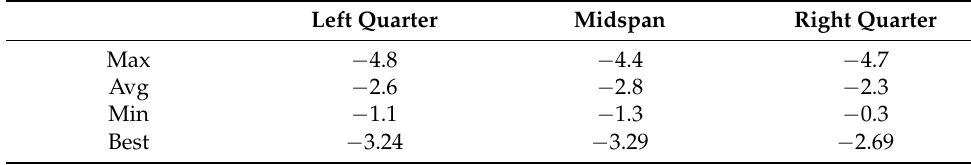
Table 4. Deformation tracking based on